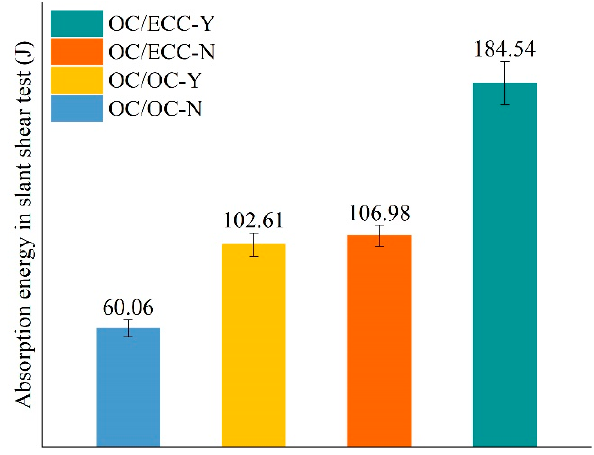
Figure 10. Absorption energy of each group in the slant shear test.